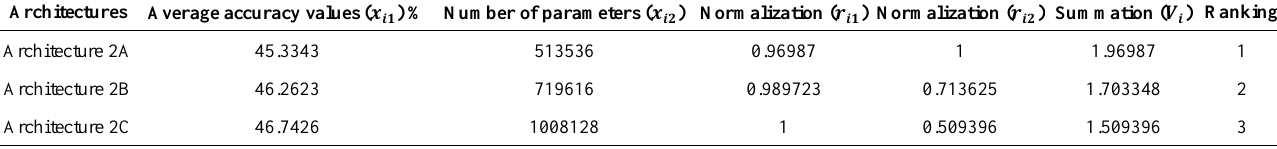
Table 6. Normalization results for the second stage of the DREAMER dataset